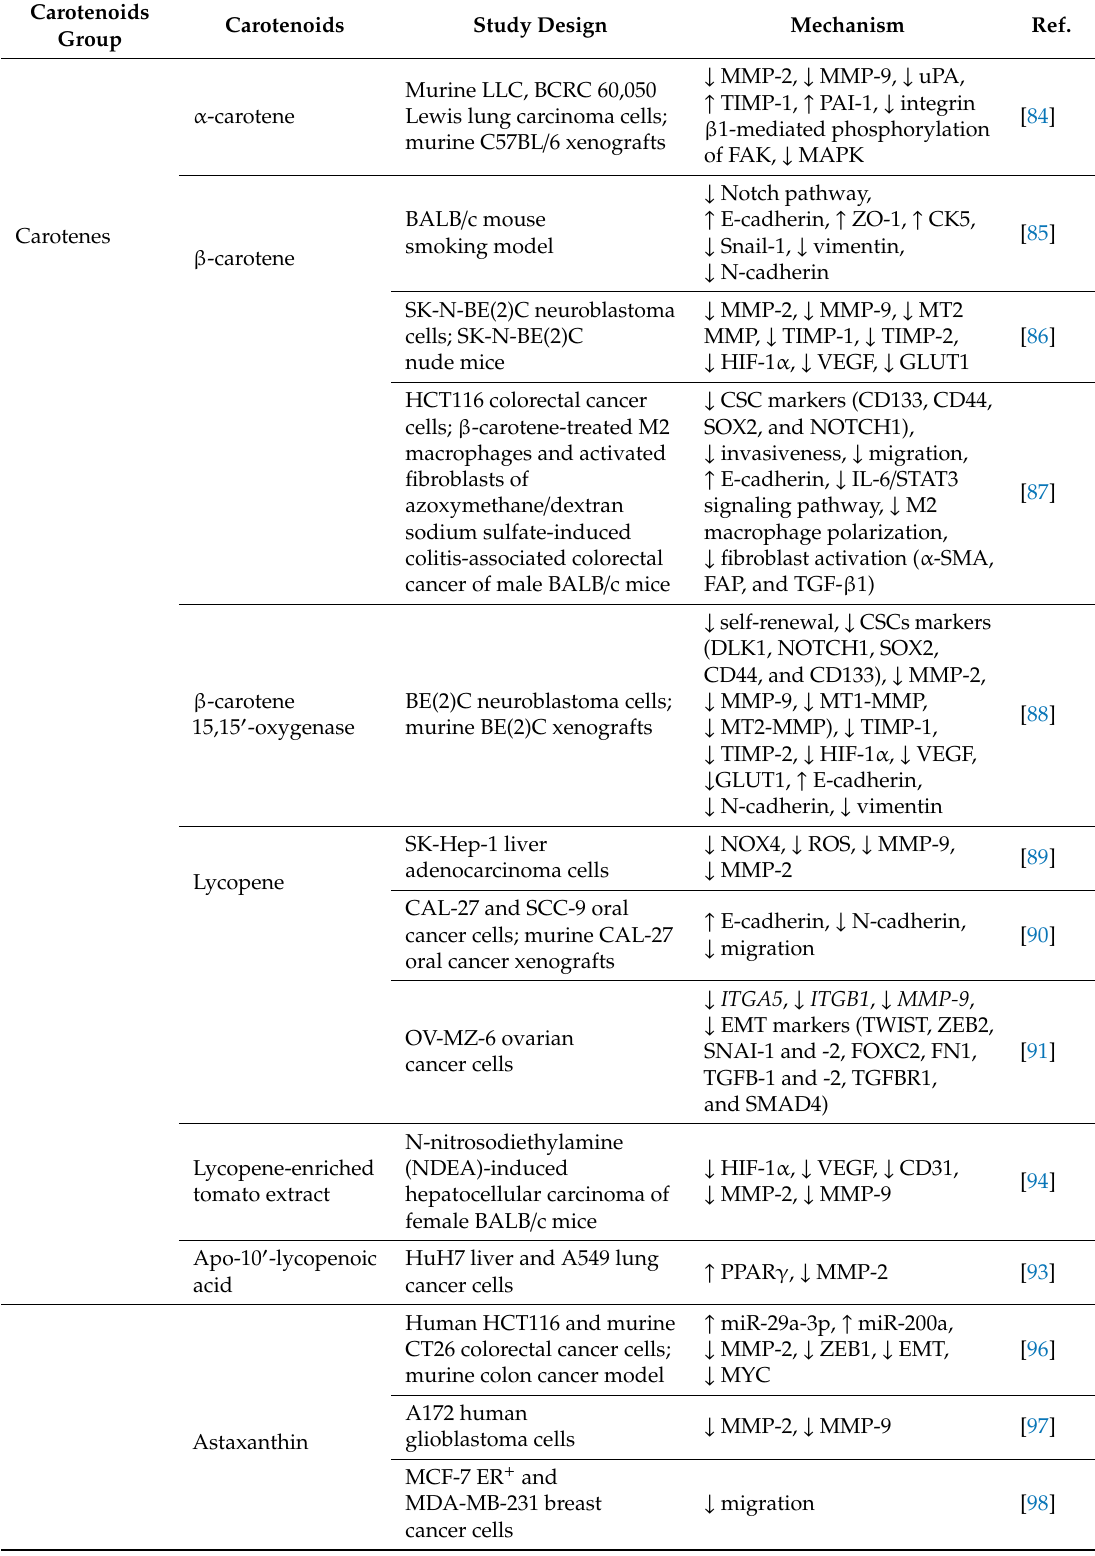
Table 1. Carotenoids targeting migration, invasion, and metastasis in preclinical cancer research.